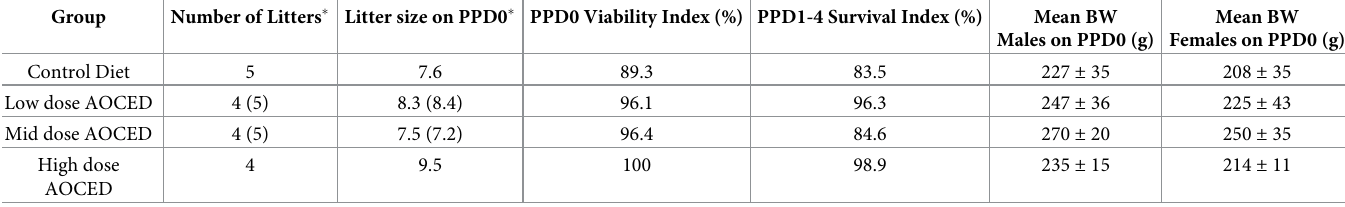
Table 4. Dams’ reproductive parameters and puppies’ viability.